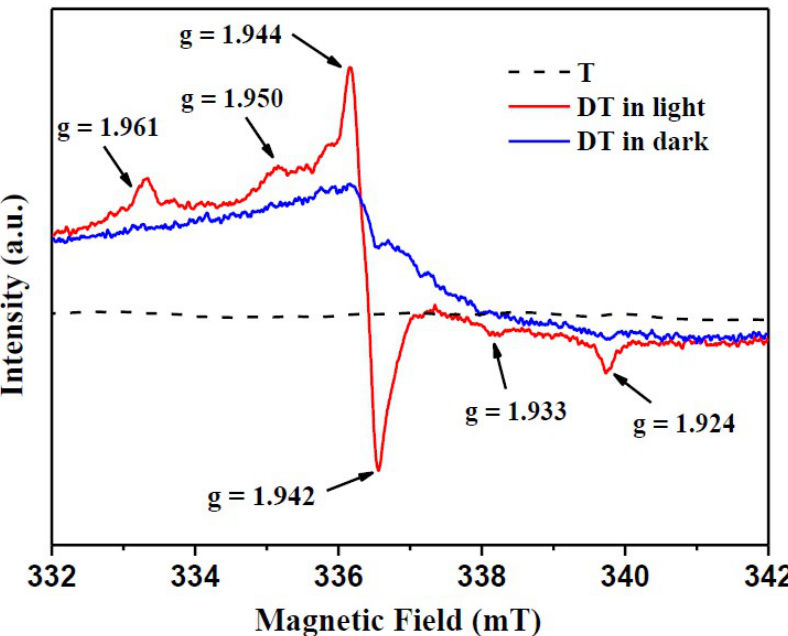
Figure 4. EPR spectra of T and DT samples, the DT sample recorded at dark and under UV irradiation (after 5 min) at room temperature. Instrument setting: operating at 9.41 GHz field modulation. modulation amplitude: 0.2 mT, power: 10 mW, gain: 5 .